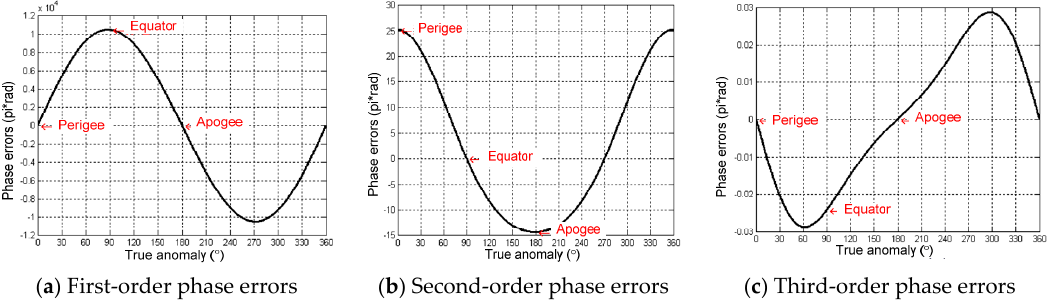
Figure 6. Phase errors of one orbit along with the true anomaly caused by the variations of eccentricity ∆ e .